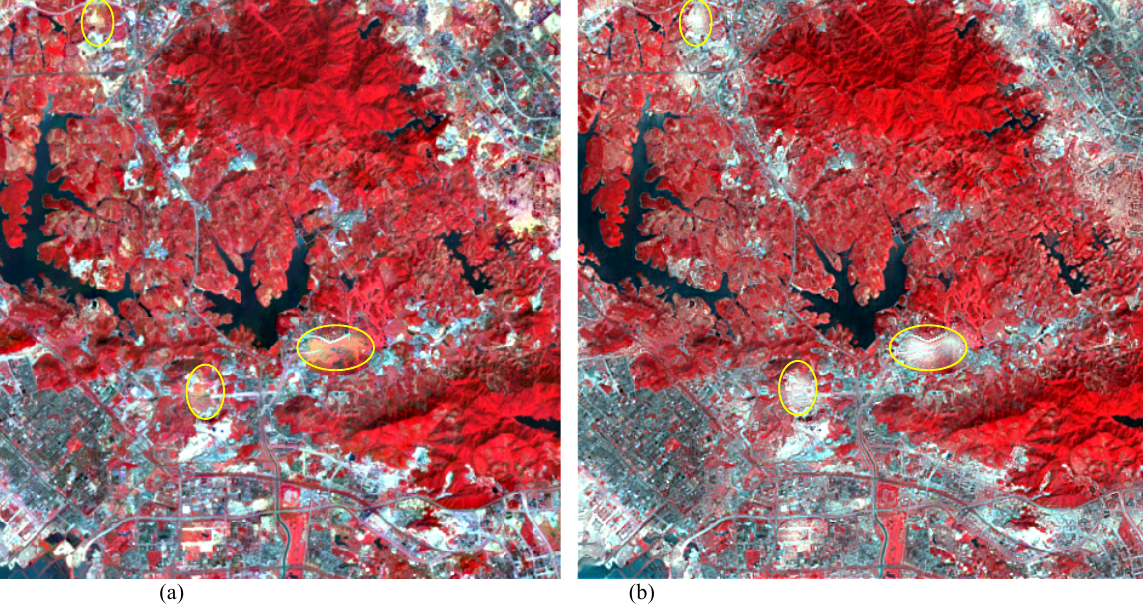
average differences (AD), Root mean square error (RMSE), erreur relative globale adimensionnelle de synthese (ERGAS) (Wald, 2002) and correlation coefficient (CC) in three bands respectively. According to the above indexes, both